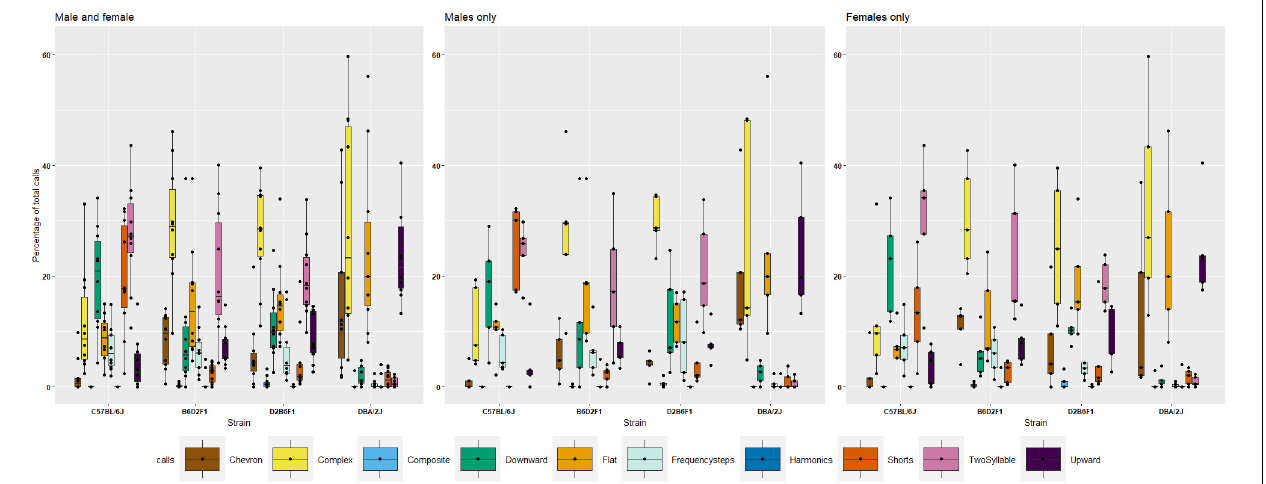
FIGURE 3 | Percentage of ten different call types in the diallel cross on postnatal day 8, showing females, males and combined values by strain. Percentages were calculated in each genotype as number of calls in each category for each subject/total number of calls analyzed in each subject. Number of total calls analyzed: B6 700; D2 = 1305; B6D2F1 = 2047 and D2B6F1 = 1972. Calls were collected from 40 individuals, one male, one female, from five litters of each of the four genotypes.